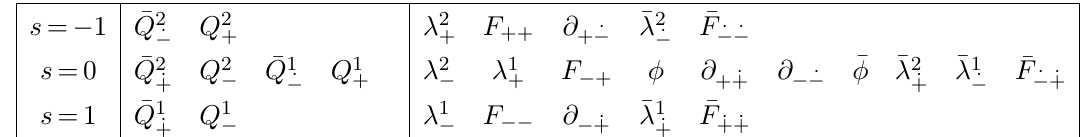
¯ multiplet, with conformal primaries having δ = 0 states empha- Figure 1 . A portion of a C R,r ( j, ¯ j ) sized in black. As described in the main text, these states can be obtained by acting with ¯ Q 1 along ˙+ with non-vanishing combinations of Q 1 and ¯ Q 2 . As we will explain in our counting discussion α ˙+ below, for our particular operators of interest, we can focus on supercharges with “ + ” and “ ˙+ ” Lorentz weights. Hence, we have only included the action of Q 1 , ¯ Q 1 , and ¯ Q 2 . Note that in the + ˙+ ˙+ case of ˆ C , some of the above states are absent due to additional shortening conditions. Of the R ( j, ¯ j ) emphasized states in the figure, there is an ( R + 1) and an ( R + 1 ) state missing ( j − 1 , ¯ j + 1 ) ( j − 1 , ¯ j +1) 2 2 2 2 for ˆ C relative to ¯ C .